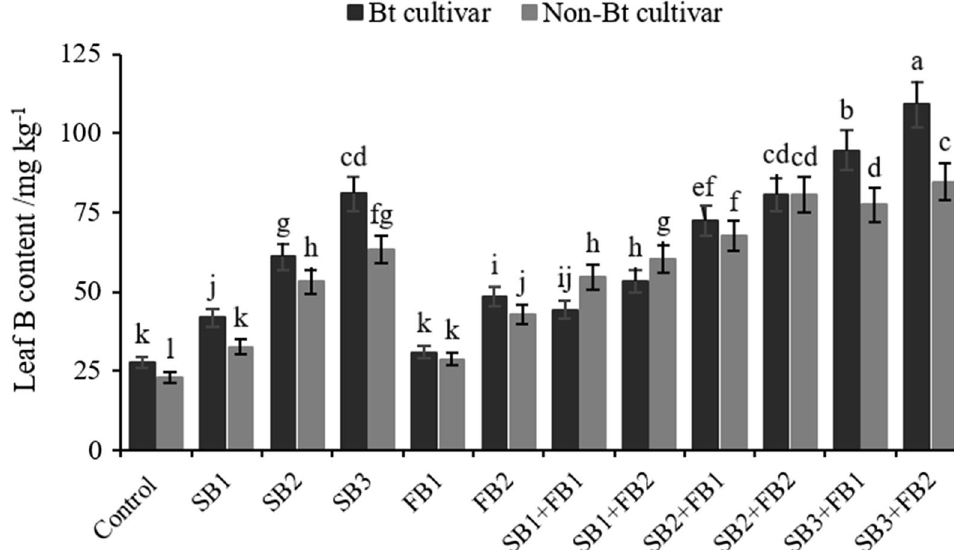
Fig. 1 Leaf B content of Bt and non-Bt cotton cultivars grown with different levels and methods of B